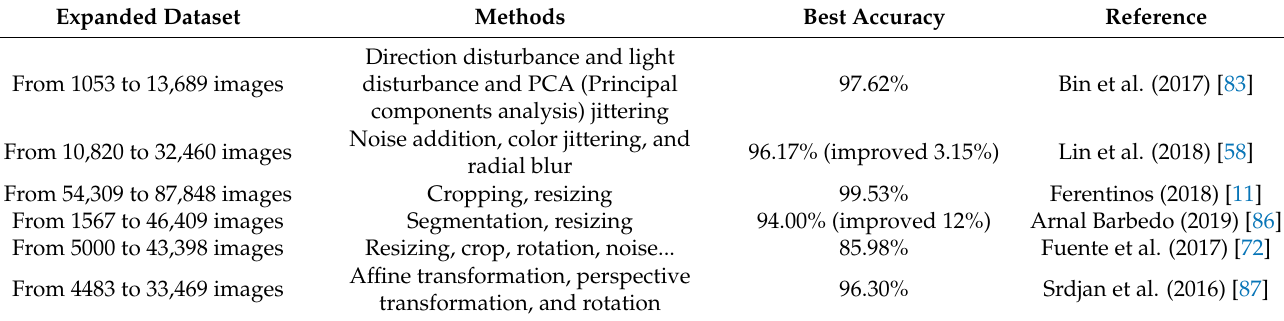
Table 4. Studies on using data augmentation technologies to expand the